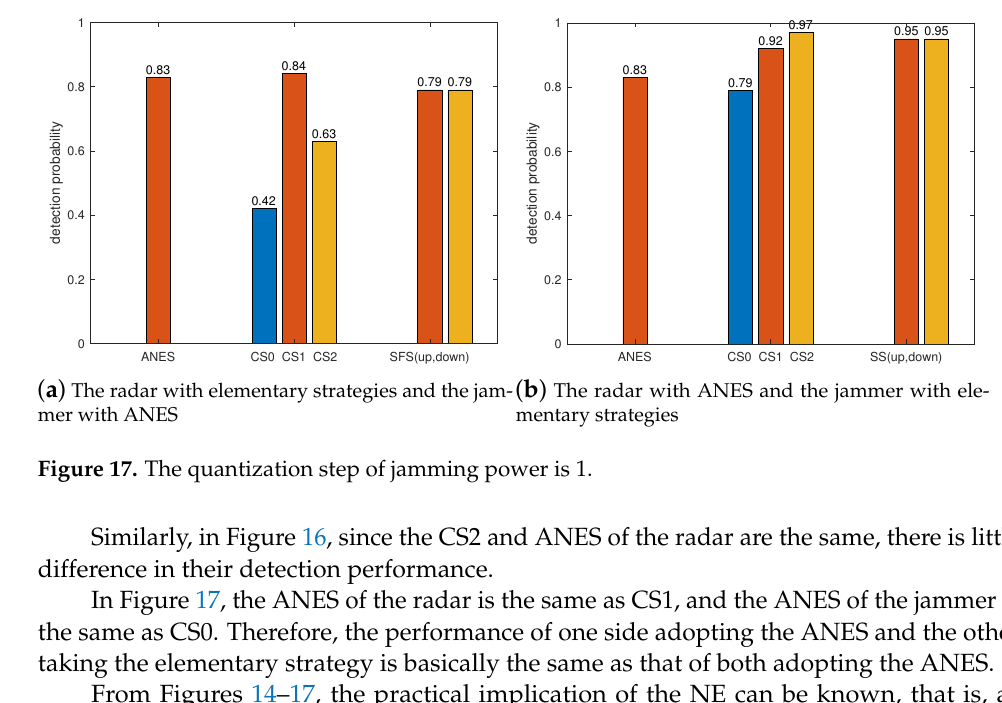
Figure 17. The quantization step of jamming power is